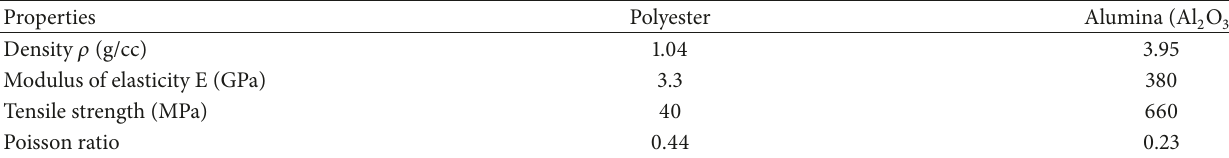
Table 1: Properties of unsaturated polyester resin and alumina.